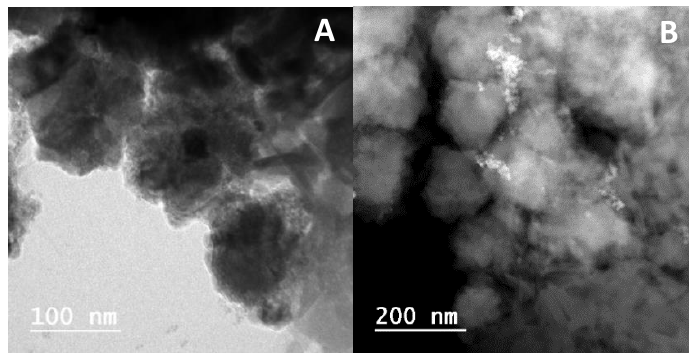
Figure 11. TEM images of magnetoliposomes containing magnetic / plasmonic NiFe 2 O 4 / Au nanoparticles: ( A ) Decorated nanoparticles. ( B ) Core / shell nanoparticles.